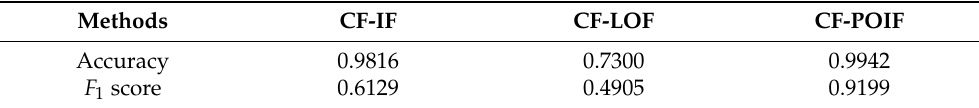
Table 3. Accuracy and F 1 score of drive end vibration